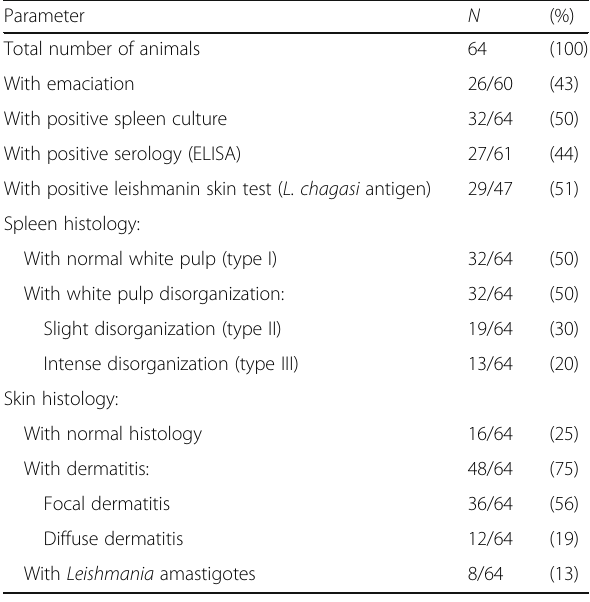
endemic area of visceral leishmaniasis that were used in this